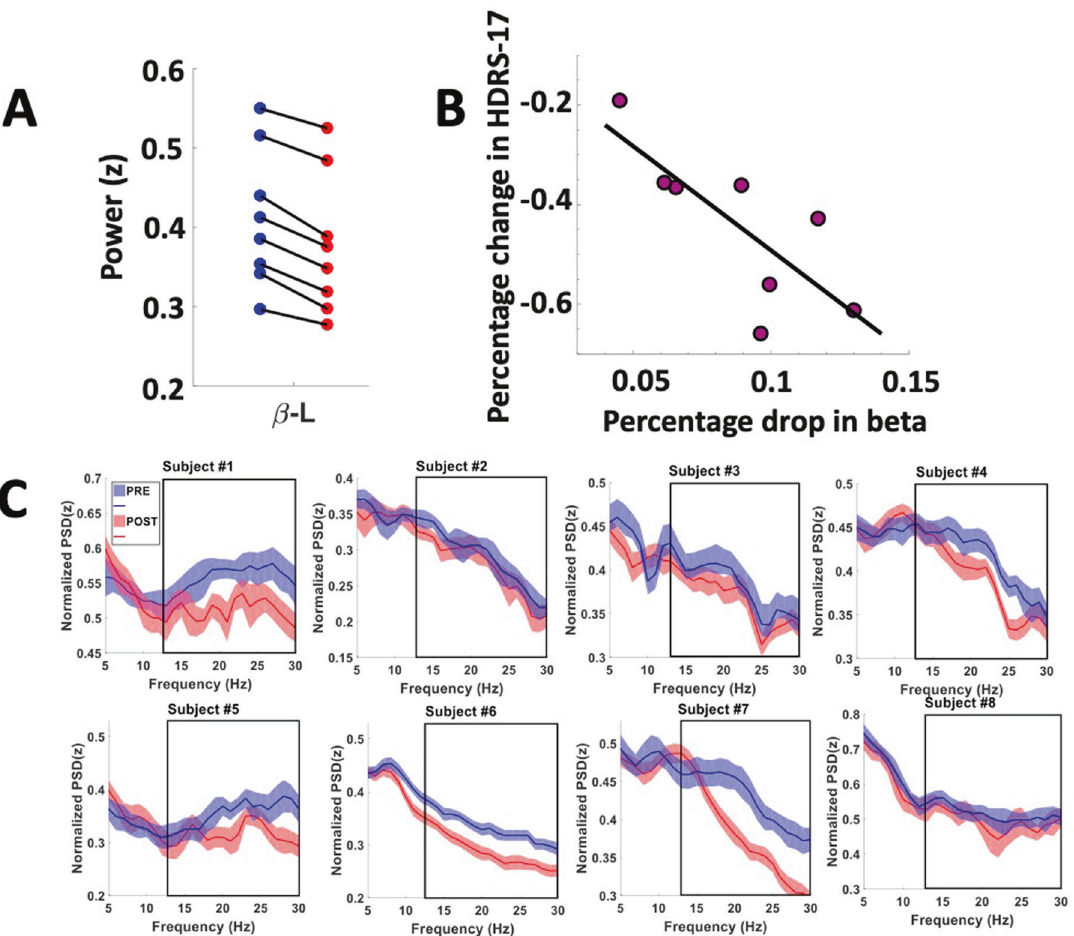
Fig. 3 Decrease in beta power following intraoperative exposure to bilateral DBS at tractography-de fi ned “ optimal ” contacts predicts early antidepressant effects. A Change in the left hemisphere beta power before (PRE: blue) and after (POST: red) exposure to DBS, F(1,7) = 96.23, p corrected < 0.001. B Left hemisphere LFP beta power decrease following intraoperative exposure to “ optimal ” DBS correlates with greater decrease in symptom severity 1 week following surgery, r (8) = 0.730, p corrected = 0.04. HDRS Hamilton Depression Rating Scale. C Intraoperative SCC-LFP power spectral density (left hemisphere) in single subjects before exposure to DBS (PRE) and after (POST). Subject-level power spectral density (PRE: blue, POST: red). Black boxes indicate time window of beta power feature (13 – 30